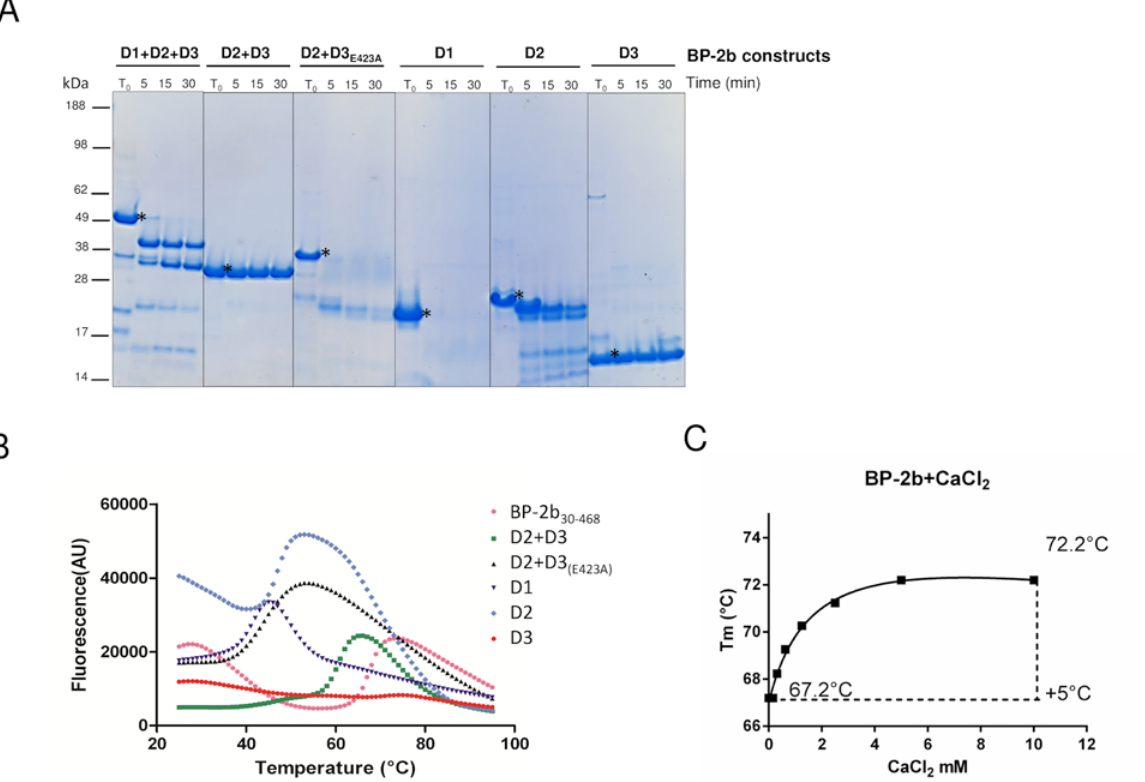
Fig 5. Biochemical characterization of different BP-2b constructs. (A) Time course of the trypsin-proteolysis reactions at 37°C of BP-2b full length and fragments, analyzed by SDS-PAGE. Different digestion patterns can be observed for the different constructs. Asterisks indicate the not-digested proteins. ( B) Differential Scanning Fluorimetry (DSF) analysis of BP-2b proteins (D1+D2+D3, D2+D3 and single domains D1, D2, D3) in presence of Sypro orange showed different thermal stabilities. Graph shows the fluorescence intensity vs . the temperature for the unfolding different BP-2b constructs. ( C) Correlation of BP-2b melting temperature with the concentration of Ca 2+